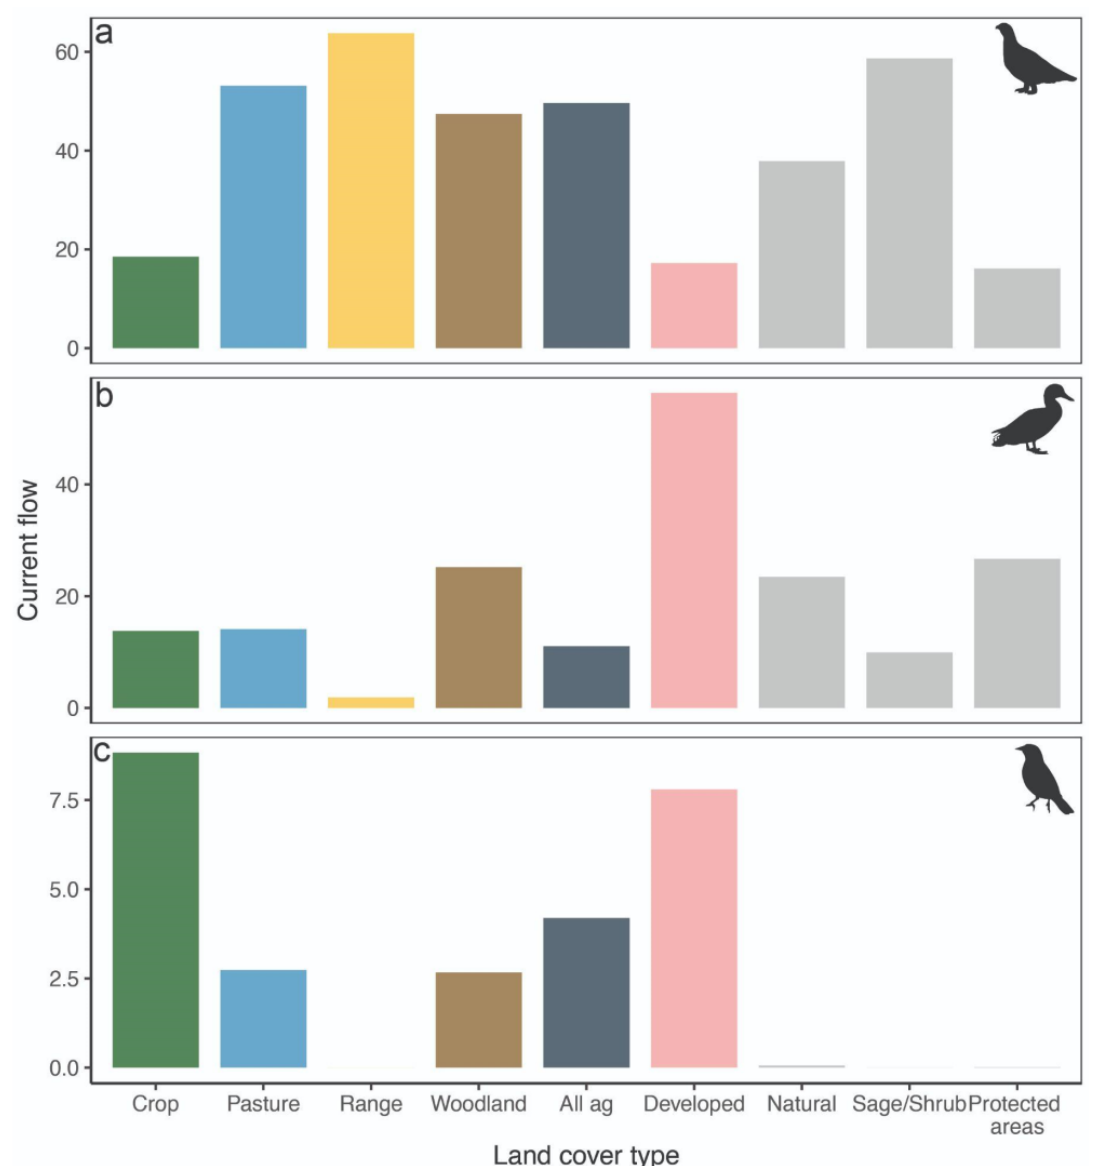
Figure 4. Median current flow values on agricultural lands (cropland, pasture, rangeland, woodland, and all agricultural categories combined (‘all ag’)) for each focal species, as compared to median current flow in developed areas and landscapes characterized by more natural land cover (i.e., all natural lands (‘natural’), areas characterized by sagebrush or other shrub cover that do not overlap with identified rangelands (‘sage/shrub’), and lands within USGS GAP 1 and GAP 2 protected areas). Recall that ‘woodland’ in this context refers to natural or planted tree cover associated with a functioning farm unit. Median current flow values are shown for ( a ) Greater sage-grouse, ( b ) American Black Duck, and ( c ) Bobolink. Note that, given differences between connectivity model inputs, current flow values are not comparable across species and should only be interpreted here in terms of relative differences between different land cover/use